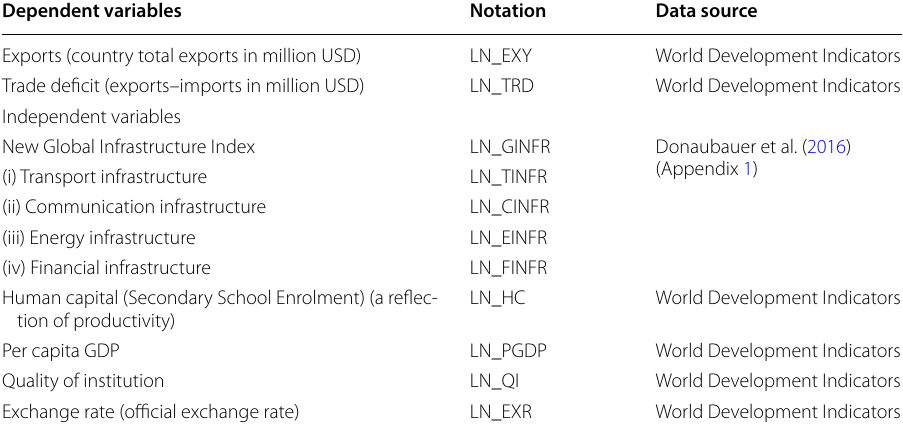
Table 1 Data description and